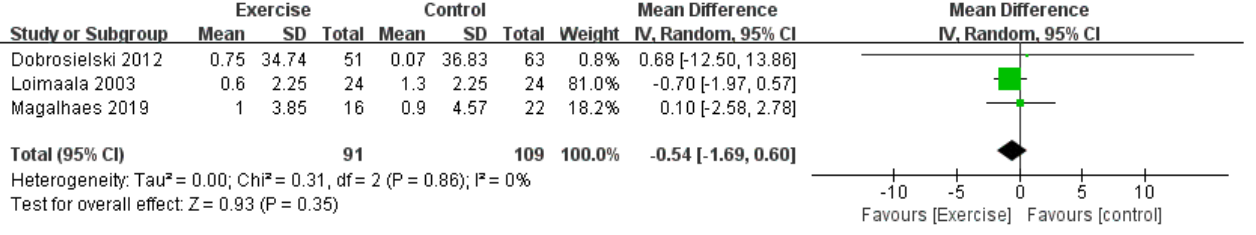
Figure 3. The pooled result of the difference of changes in pulse wave velocity between two groups [35,37,38].